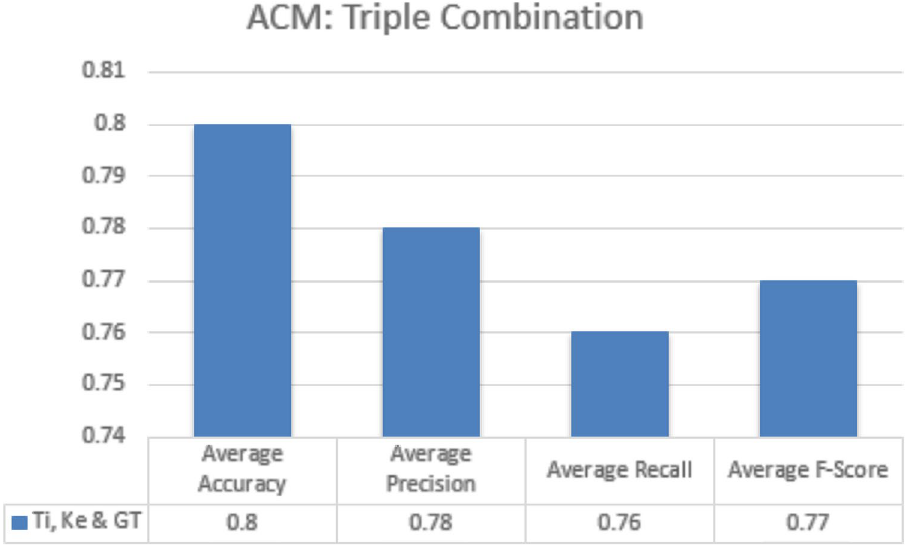
Figure 12. ACM (triple